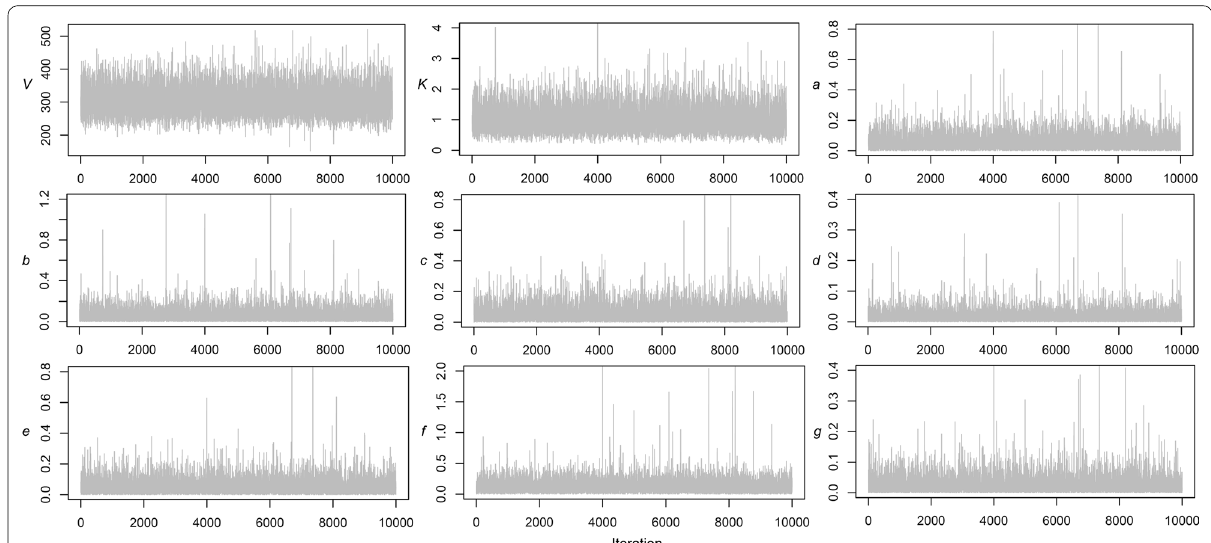
Fig. 3 Traces of the MCMC samples of V (1000 tonnes), K , a , b , c , d , e , f and g . The chain length was set to 1,000,000 steps logging every 100th step. V , maximum production; K , half-saturated suitability; a , effect of rainfall; b , effect of sea water CO 2 concentration; c , effect of temperature; d , effect of typhoon; e , effect of solar radiation; f , effect of sea water nutrient level; g , effect of sea water